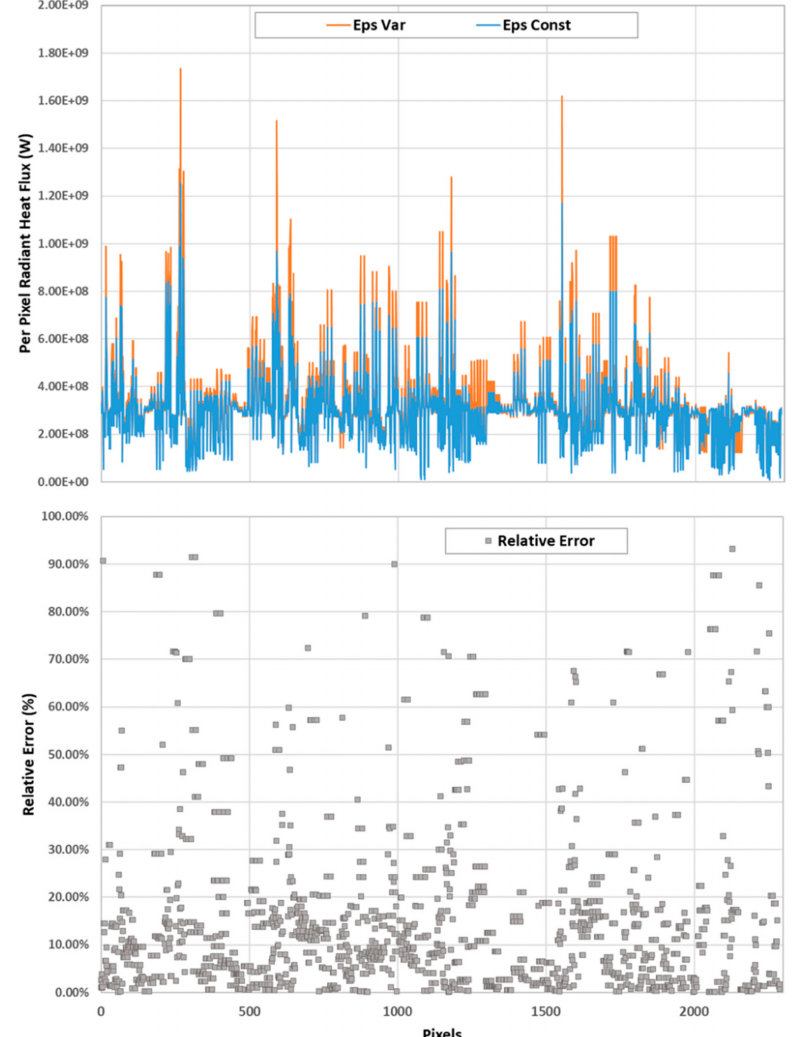
Figure 10. ( Top )—Per pixel radiant heat flux for variable emissivity (orange) and constant emis- sivity (blue). ( Bottom )—Relative error (grey squares) computed for MODIS images during 15 July–30 August 2001 at Mt.